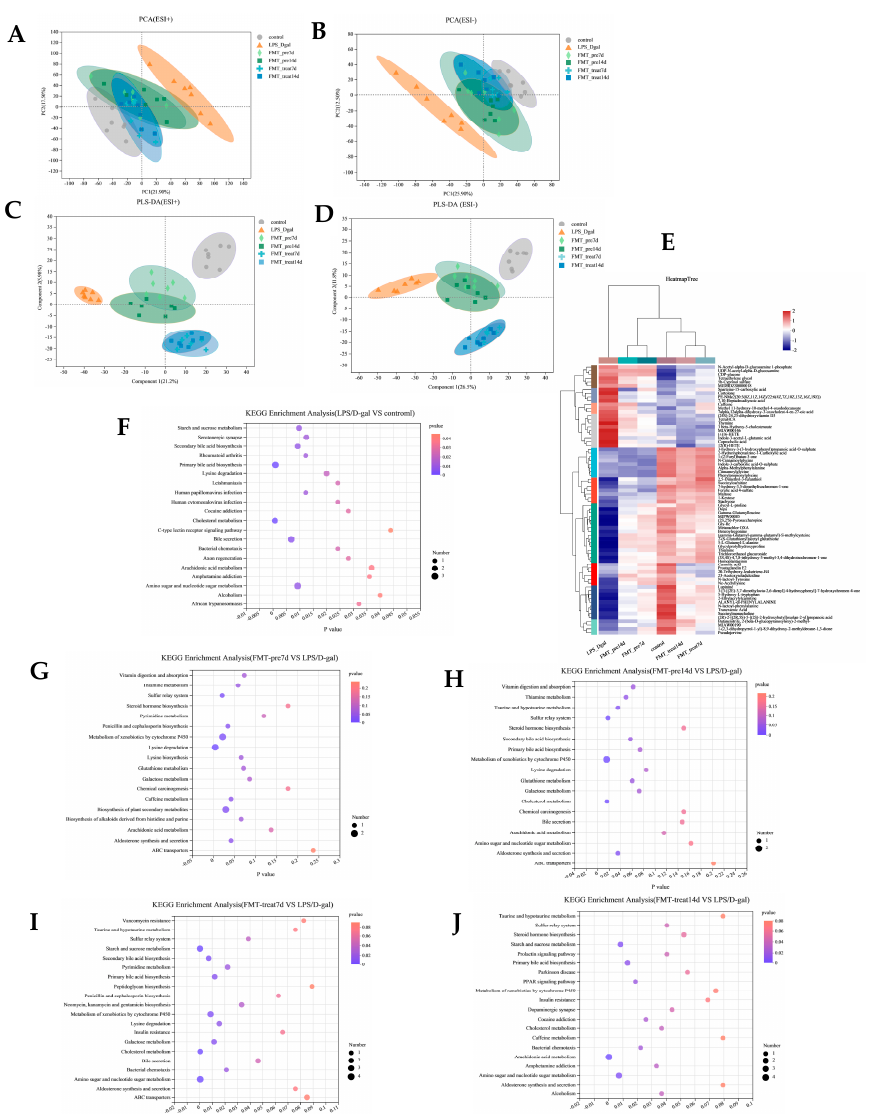
Figure 5. FMT altered liver metabolome. ( A , B ) PCA score plots f nontargeted metabolite profiling of the liver samples among the six groups in both positive (ESI+) and negative ionization modes (ESI − ). ( C , D ) PLS-DA scores of metabolite analysis in ESI+ and ESI − modes. ( E ) Heatmap of liver metabolites from six groups. ( F – J ) Bubble diagram showing the KEGG enrichment analysis. Shade of color represents the differences, while bubble size represents the number of enrichments. ( n = 6–7). Compared with the LPS/D-gal group, both the FMT-treat7d and FMT-treat14d groups exhibited a decrease in metabolites of nucleotide sugar and amino sugar metabolites, such as UDP-N-acetyl-alpha-D-glucosamine, N-acetyl-alpha-d-glucosamine 1-phosphate, and CDP-glucose, and an increase in metabolites issued from xenobiotic metabolism by cytochrome P450 (trichloroethanol glucuronide, 2-(S-Glutathionyl)acetyl glutathione, and 1-methylguanosine), and starch and sucrose metabolites (UDP-glucose, CDP-glucose, and maltose). In addition, we found that cholesterol metabolites (number of metabolites = 2, p = 0.0005) were down-regulated in the FMT-treat 7 d group significantly and arachidonic acid metabolites (number of metabolites = 4, p = 0.0002) were notably down-regulated in the FMT-treat 14 d group (Figure